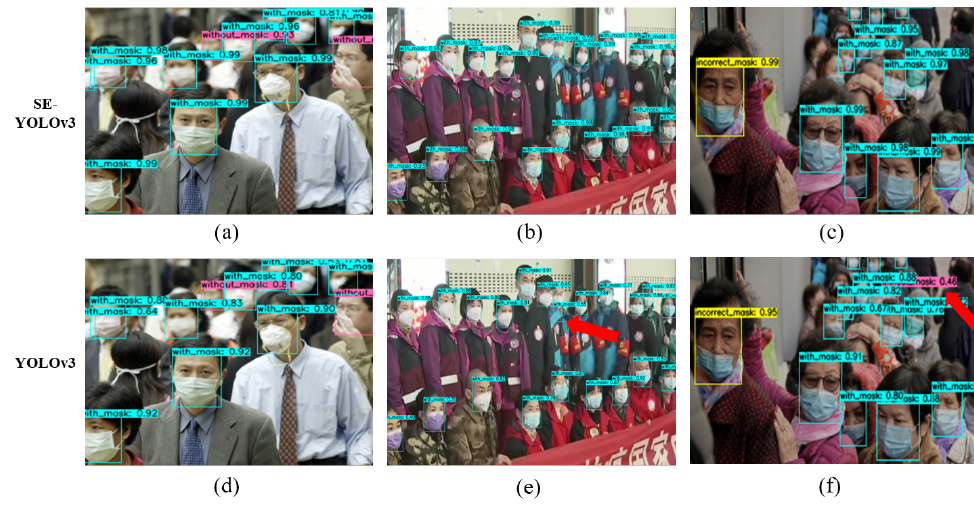
Figure 5. Face detection results of SE-YOLOv3 and the original YOLOv3 (the red arrow indicates the false detection result). ( a – c ) are testing results of SE-YOLOv3 and ( d – f ) are testing results of